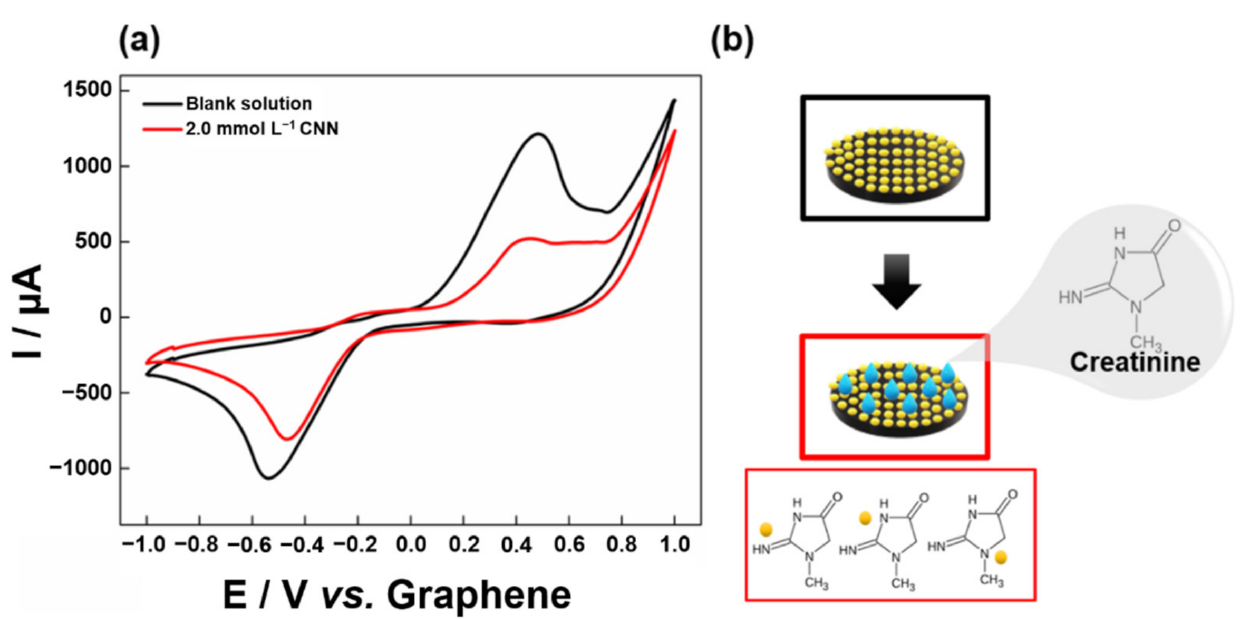
Figure 2. ( a ) Cyclic voltammograms of blank solution (black line) and (red line) 2.0 mmol L − 1 CNN using Au/G-PLA electrode. Supporting electrolyte: 0.5 mol L − 1 NaCl. Scan rate: 100 mV s − 1 , ( b ) Schematic illustration of the interaction of creatinine with AuPs.